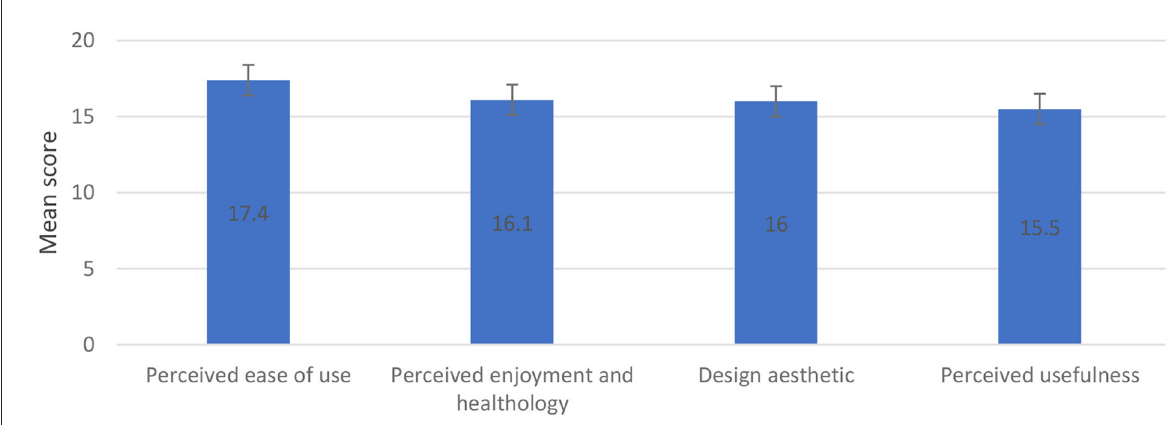
FIGURE2 Mean distribution of design aesthetics perceived usefulness, ease of use, enjoyment and healthology.